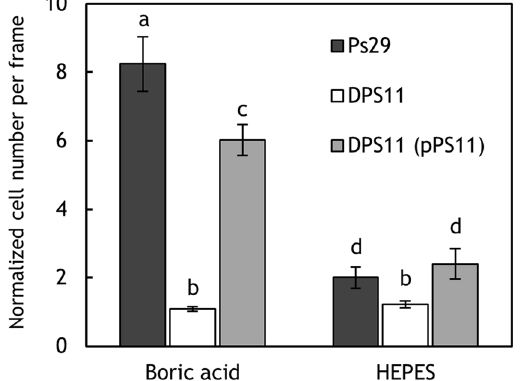
Figure 3. Chemotactic response of R. pseudosolanacearum Ps29 strains to 0.1 mM boric acid. Ps29, wild type; DPS11, mcpB deletion mutant; DPS11 (pPS11), DPS11 harboring pPS11. The normalized cell number was calculated by dividing the number of bacterial cells observed at 1.5 min by the number observed at the initiation of the experiment. Vertical bars represent the standard error of measurement for experiments performed at least in triplicate. Different letters indicate significant differences ( P < 0.05 by Student’s t